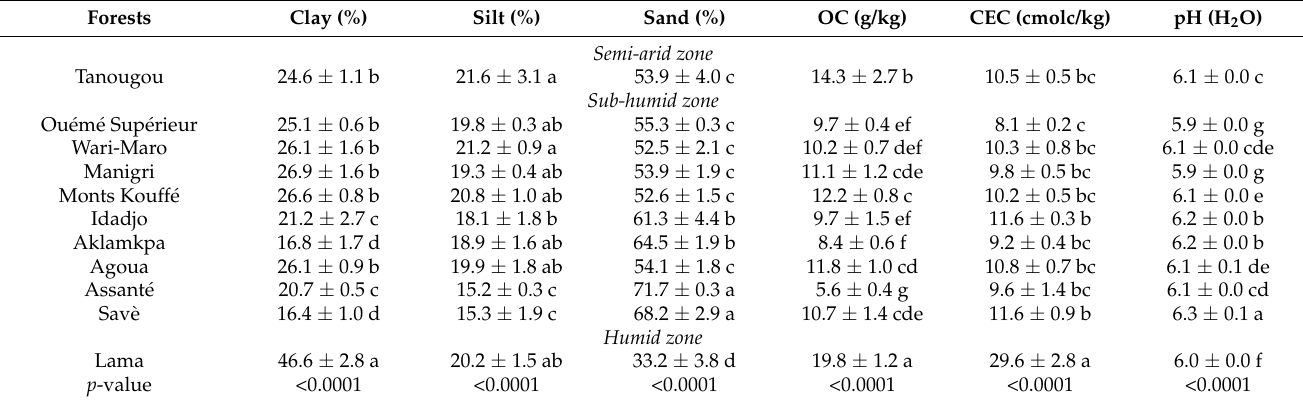
Table 4. Soil characteristics (means ± SD) in the investigated forests.